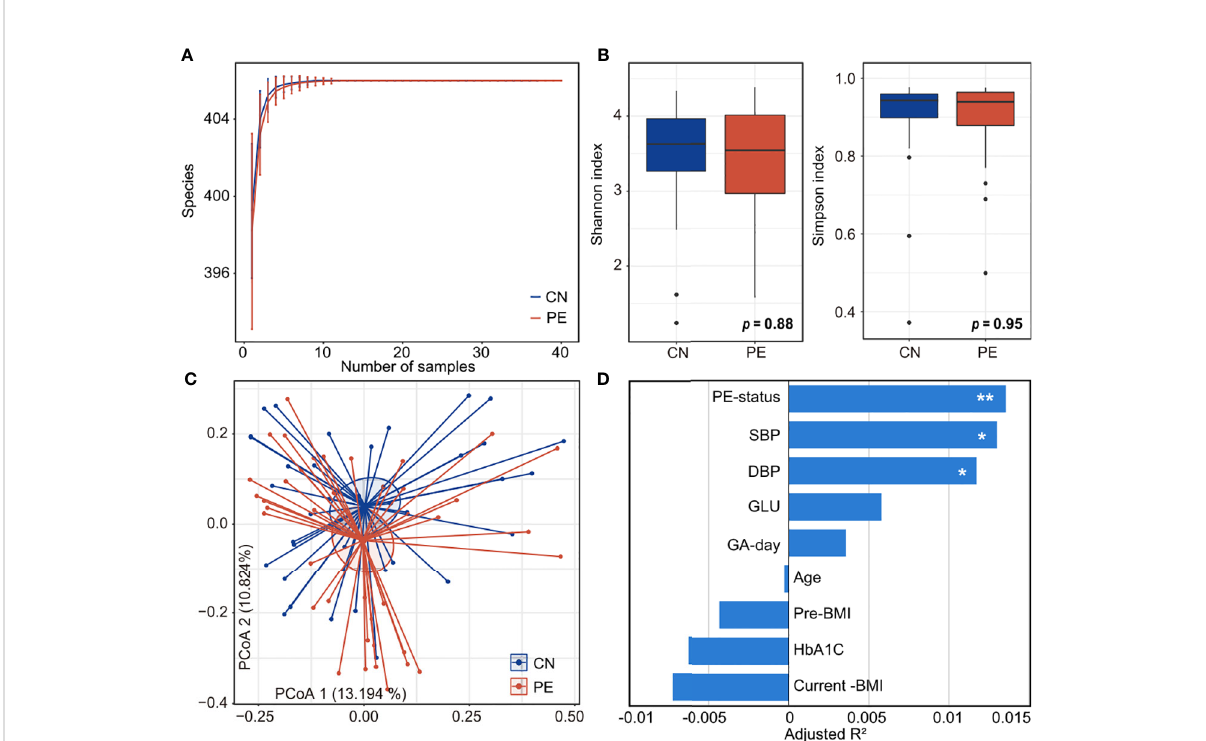
FIGURE 2 Comparison of microbial diversity and structure in PE patients and healthy controls. (A) Rarefaction curve analysis of the number of observed species in two groups. The number of species in different groups is calculated based on a randomly selected speci fi c number of samples with 30 replacements, and the median and quartile values are shown. (B) Boxplot shows the Shannon and Simpson diversity indexes of gut microbiota that differ among the two groups. Boxes represent the interquartile range between the fi rst and third quartiles and median (internal line); whiskers denote the lowest and highest values within 1.5 times the range of the fi rst and third quartiles, respectively; and nodes represent outliers beyond the whiskers. (C) PCoA analysis of Bray-Curtis distance based on the composition of gut microbiota, revealing the separation between the PE patients and healthy controls. The location of samples (represented by nodes) in the fi rst two principal coordinates is shown. Lines connect samples in the same group, and circles cover samples near the center of gravity for each group. (D) PERMANOVA analysis showing the effect size of phenotype indexes that contribute to the variance of the overall gut microbiome. Bar plots indicate the explained variation (adjusted R 2 ) of each factor. Adonis test: *, permutated p <0.05; **, permutated p <0.01. SBP, systolic blood pressure; DBP, diastolic blood pressure; GLU, fasting blood glucose; GA-day, gestational age (day); Pre-BMI, pre-pregnancy body mass